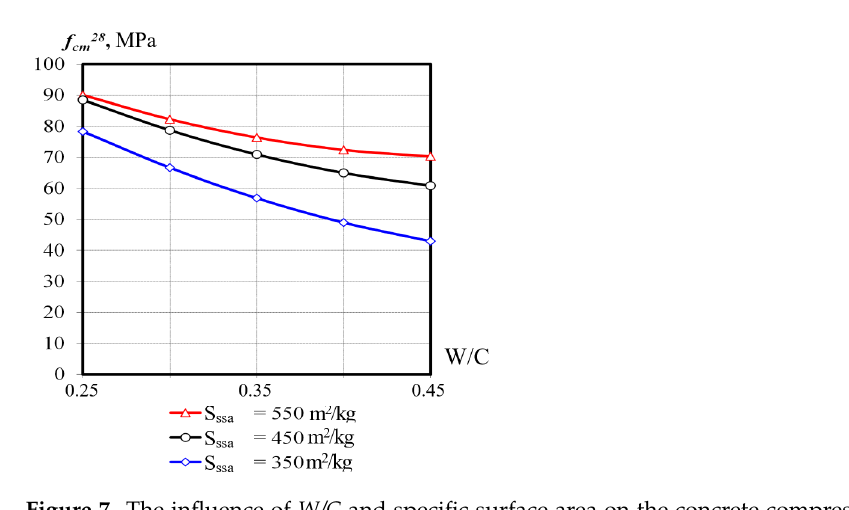
Figure 6. The influence of W/C and PFM 1 content on the concrete compressive strength at the 1 day (S ssa = 450 m 2 /kg).